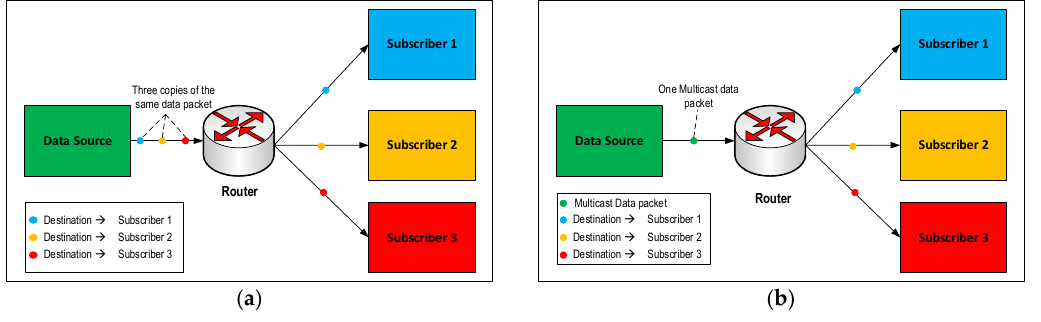
Figure 6. ( a ) Unicast communication; and ( b ) multicast communication.